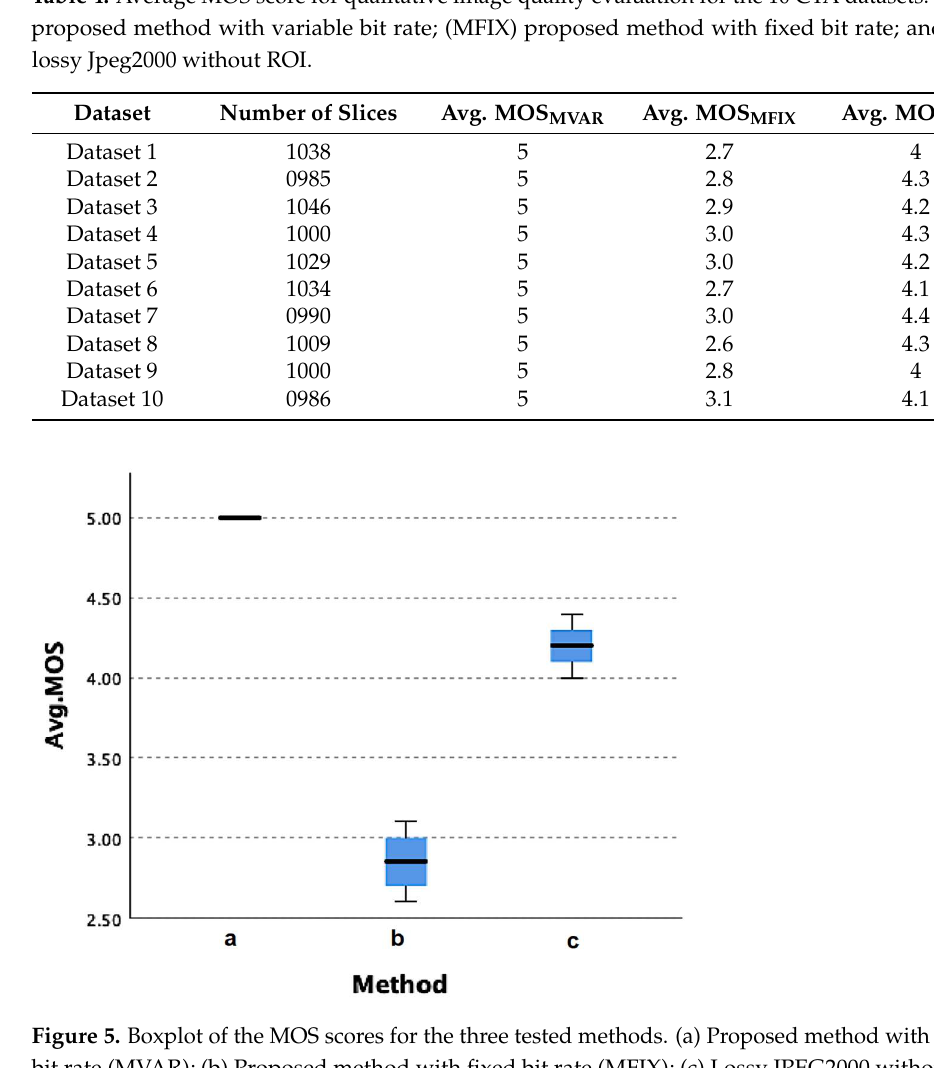
Table 3. Average slice size and Global MSE across the full 10 CTA dataset.